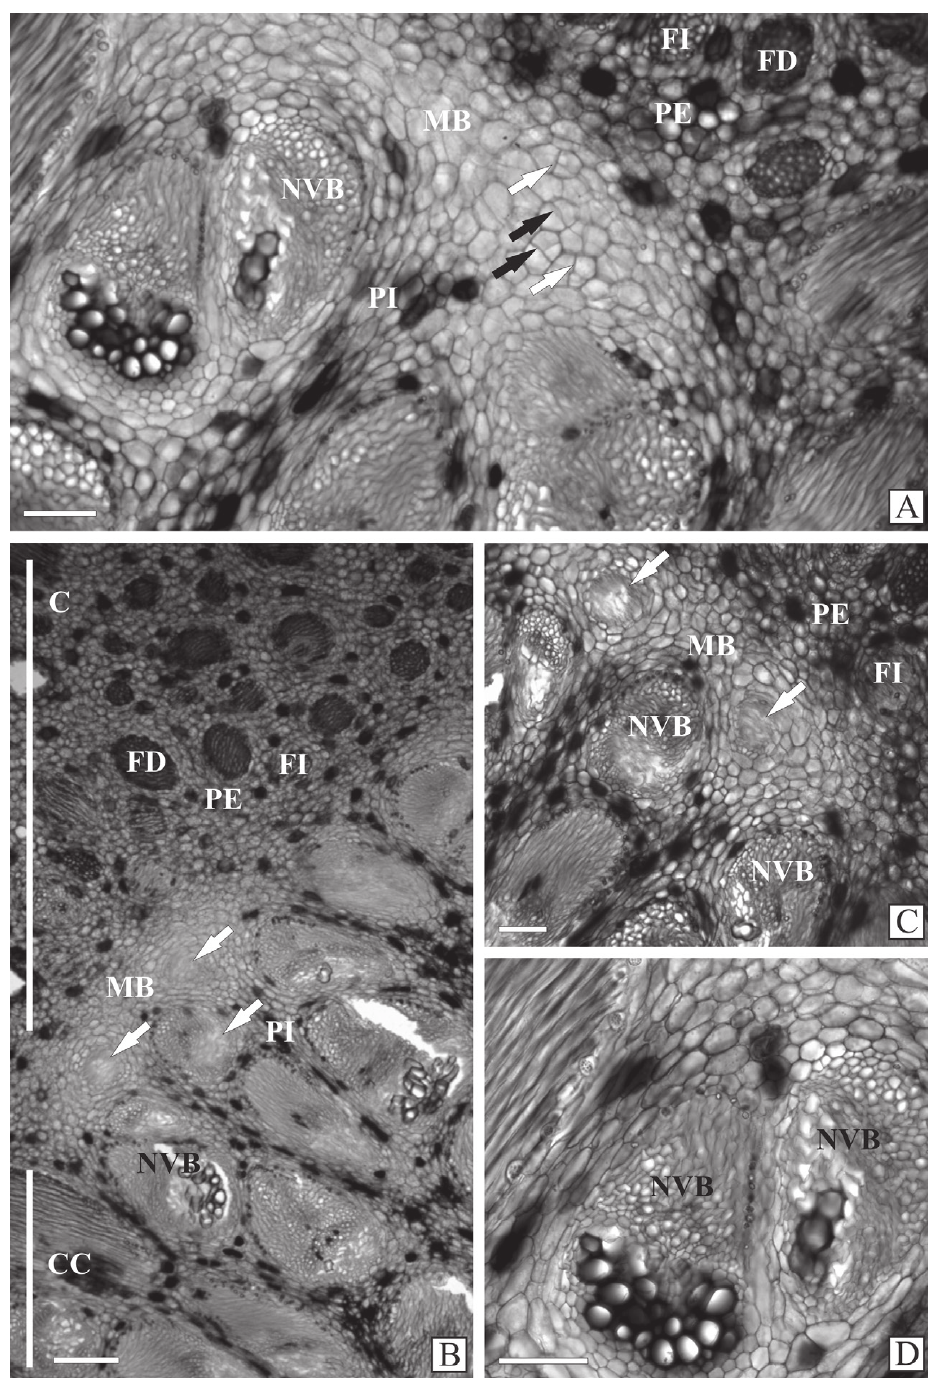
Figure 3 - A - D. Syagrus romanzoffiana . young plant. Transverse sections of the stem at the interface between the cortex and the central cylinder, showing the meristematic band and its products. A. Detail of the meristematic band showing periclinal divisions (black arrows) and anticlinal divisions (white arrows). B - C. Newly formed vascular bundles appear embedded on the meristematic band (white arrows). D. Detail of two differentiating new vascular bundles. C: cortex, CC: central cylinder, FD: differentiated fiber strand, FI: immature fiber strand, MB: meristematic band, PE: external secondary parenchyma cells, PI: internal secondary parenchyma cells, NVB: new vascular bundle. Scale bars: 100 µm (A, C, D) ; 200 µm (B)